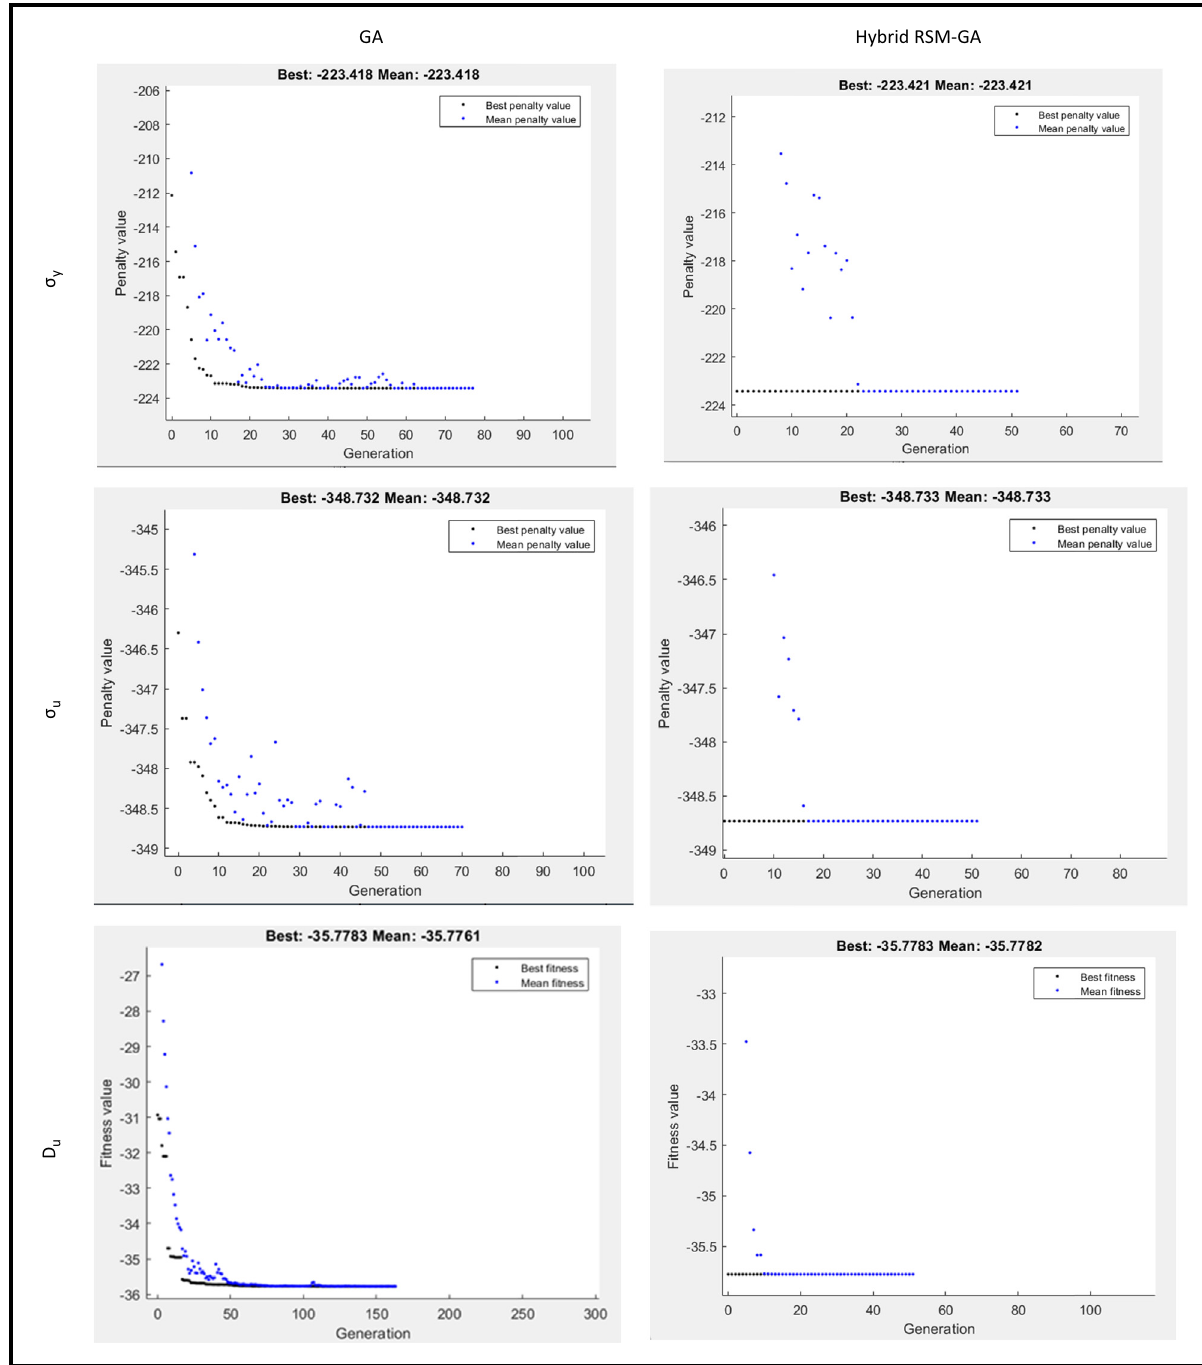
Figure 25: Optimum σ y , σ u , and D u by GA and hybrid RSM –